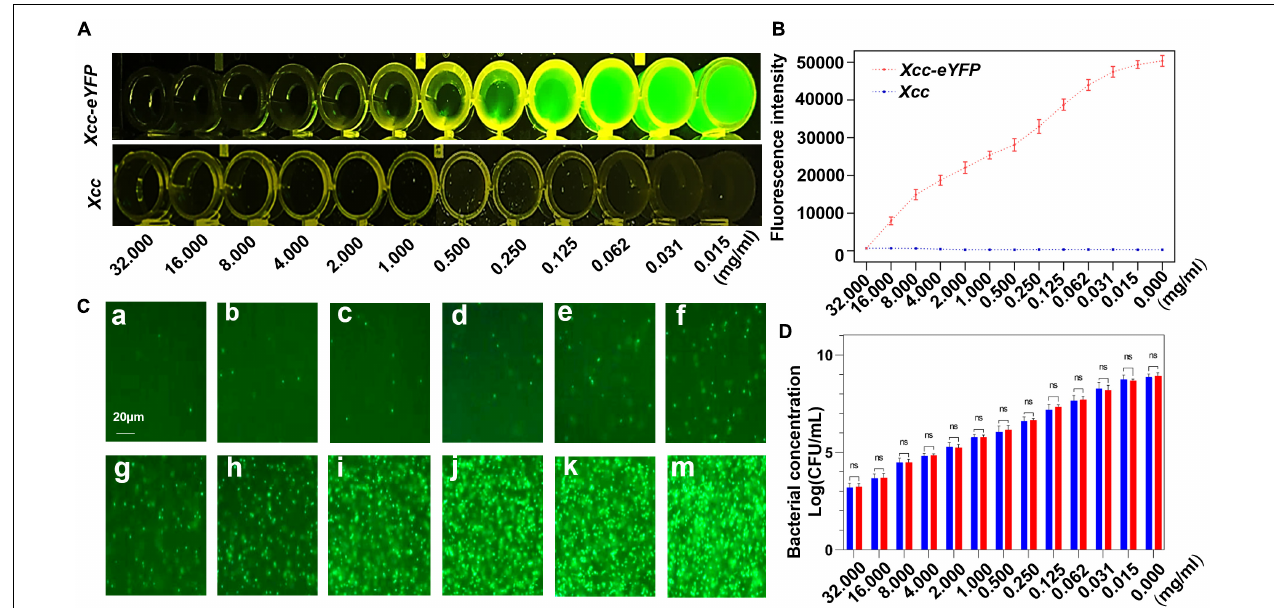
FIGURE 1 | The correlation between fluorescence reading and the alive bacterial population of Xcc-eYFP . (A) After 6 h of incubation, Xanthomonas citri subsp. citri ( Xcc ) and Xcc-eYFP express fluorescence signals, at 12 concentrations of 30% copper oxychloride (SC), were captured under LUYOR-3145RG irradiation. (B) After 6 h of incubation, Xcc and Xcc-eYFP express fluorescence intensity, at 12 concentrations of 30% copper oxychloride (SC), were captured under the Spark TM multimode microplate reader (TECAN, Switzerland). Means and SDs of five replicates of a representative result are shown. Vertical bars represent the SD of the means. (C) Xcc-eYFP suspension (OD = 1) was co-incubated with a series of 30% copper oxychloride (SC) concentrations of a = 32, b = 16, c = 8, d = 4, e = 2, f = 1, g = 0.5, h = 0.25, i = 0.125, j = 0.062, k = 0.031, m = 0.015 mg/ml, after 6 h of incubation, The fluorescence of Xcc-eYFP footprint was captured through a transmission fluorescence microscope. (D) Alive bacterial concentrations of Xcc and Xcc-eYFP were counted by the plate colony counting method and fluorescent spots counting method. Means and SDs of the three replicates of a representative result are shown. Error bars are representative of the SD from the mean. Statistical analysis was studied with the Tukey’s test (95% confidence interval (CI), nsP >0.05). ddH 2 O, double-distilled water.